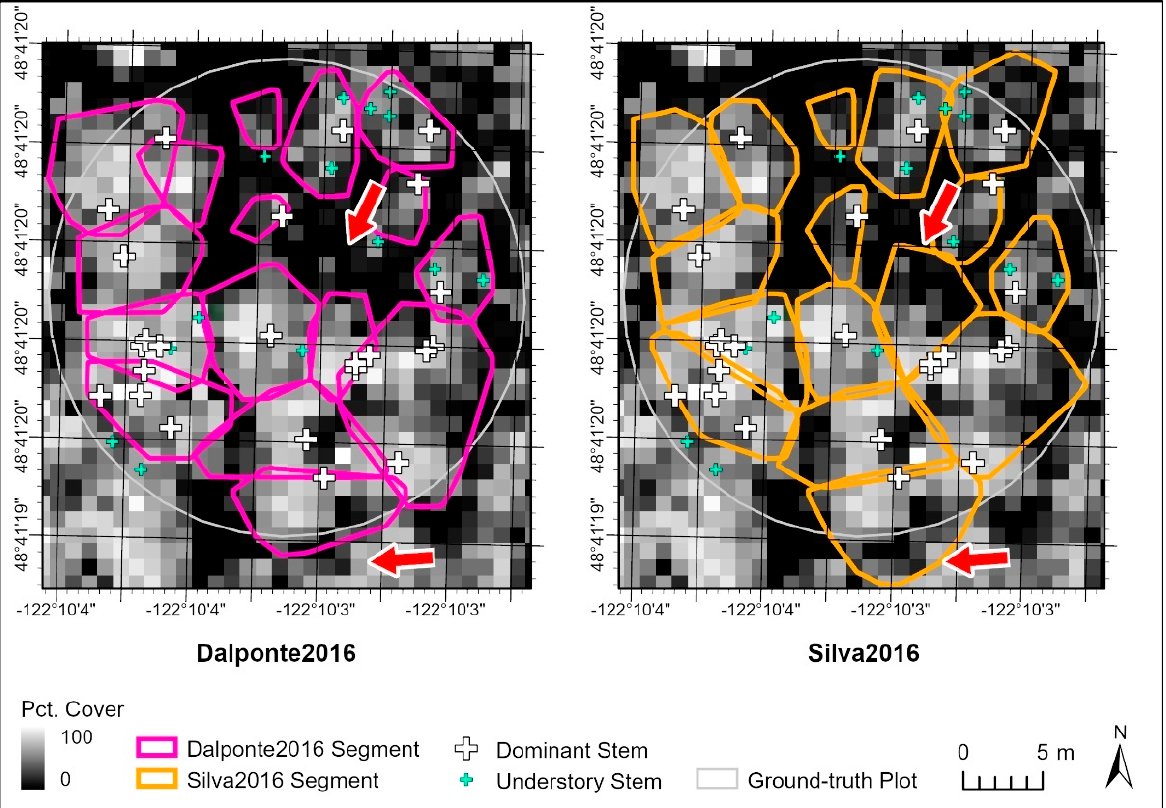
Figure 3. Comparison of the Dalponte2016 and Silva2016 segmentation outputs in plot 68. The Silva2016 algorithm tended to over-grow into canopy gap regions (see arrows).